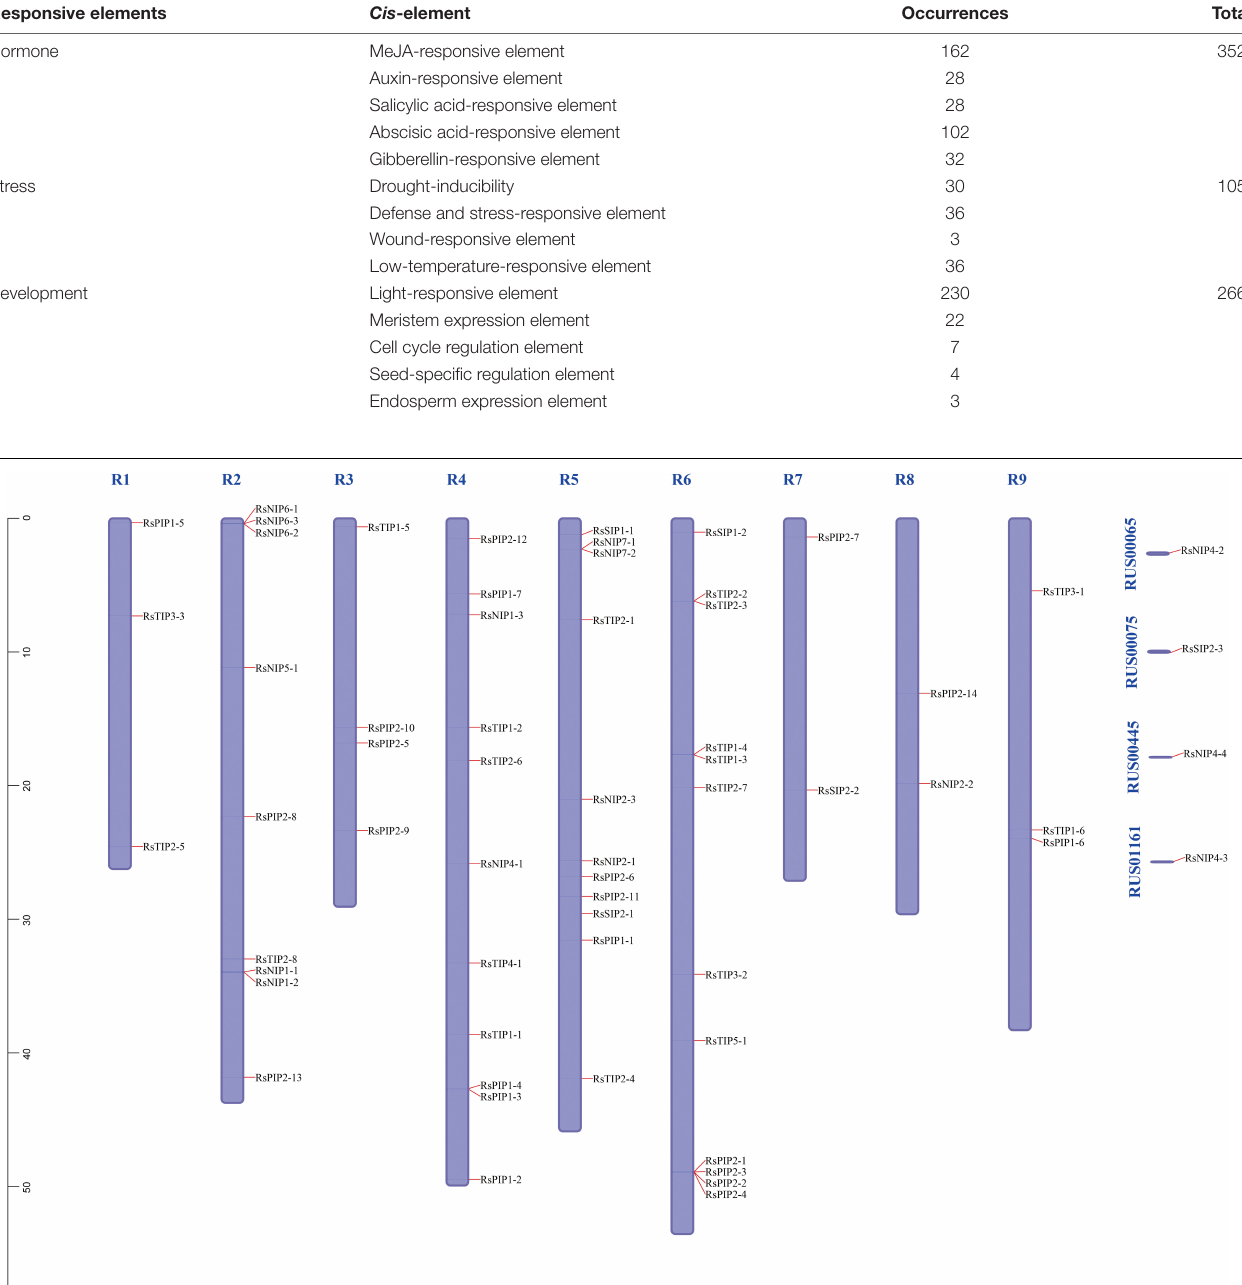
TABLE 2 | Number of occurrences of each cis -acting element in the RsAQP promoter.